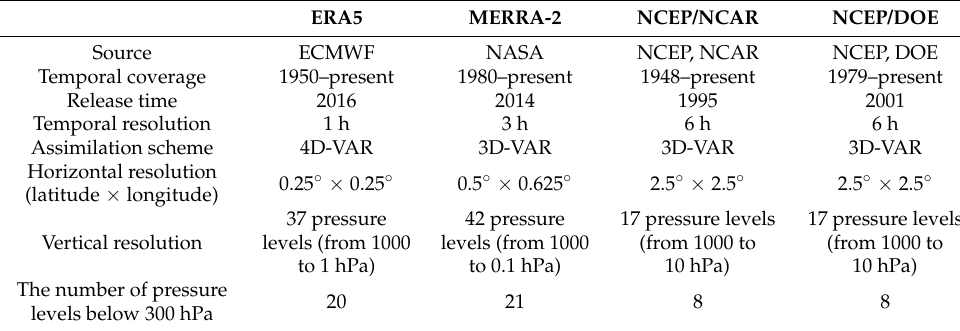
Table 1. Basic information of the four reanalysis